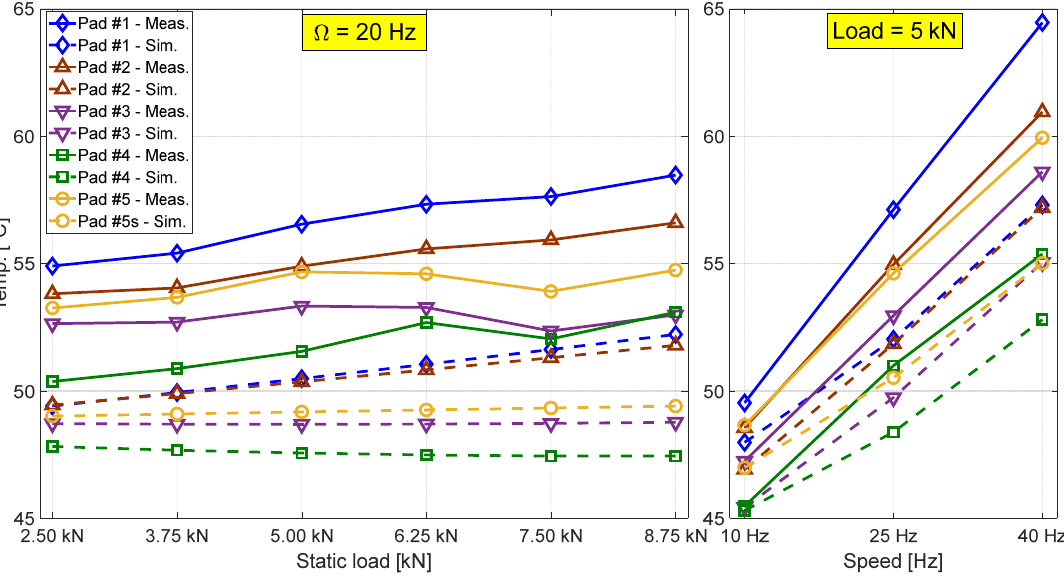
Figure 17. Measured and predicted temperature of pad #1 and pad #4 vs. static load ( left ) and rotational speed ( right ) in the test bearing.